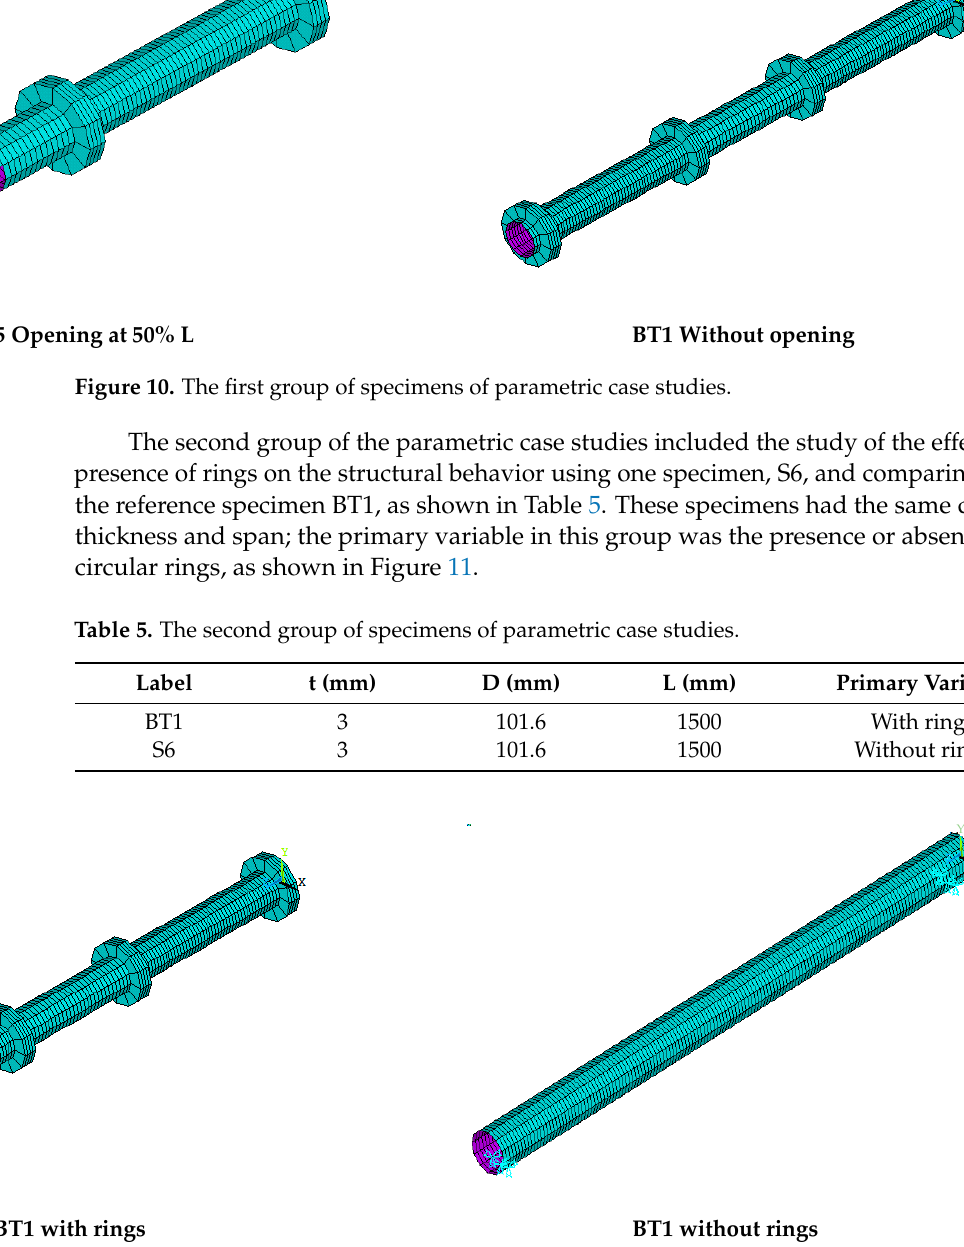
Figure 11 . The second group of specimens of parametric case studies. Figure 11. The second group of specimens of parametric case Figure 11. The second group of specimens of parametric case studies.